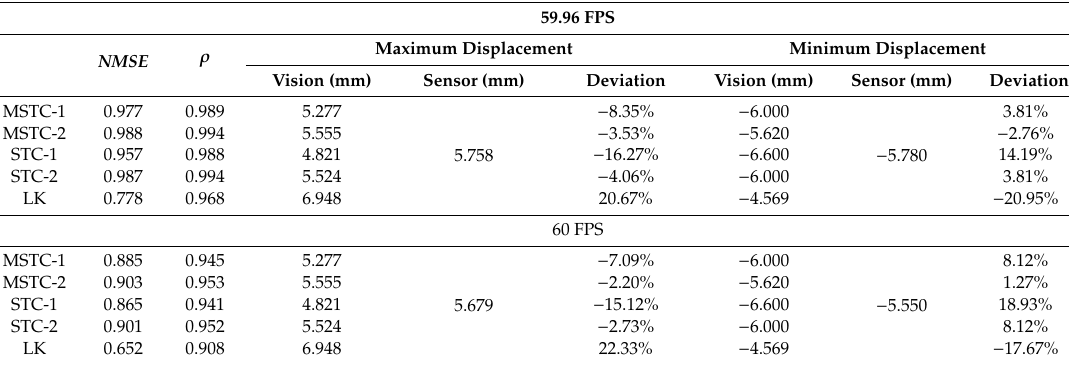
Table 4. Evaluation of displacement results with illumination variation.